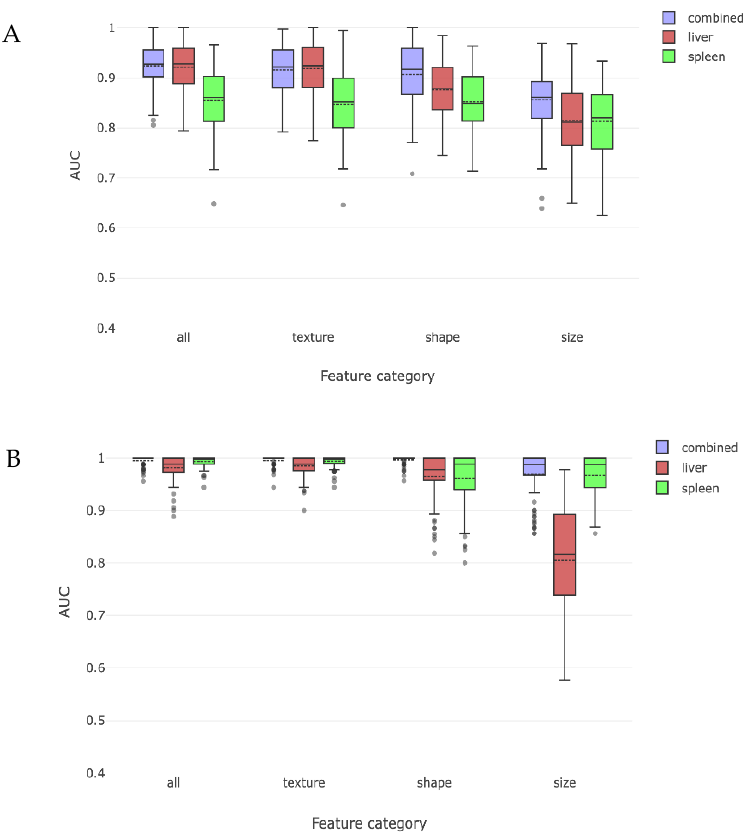
Figure 4. These two figures depict the radiomic discrimination of cirrhosis between non-cirrhosis cohort and either compensated ( A ) or decompensated ( B ) cirrhosis sub-cohorts. Discrimination is more effective for decompensated sub-cohort. Liver features are more effective than spleen features from discriminating compensated subjects, while spleen features become more effective than liver features for decompensated subjects. Texture and shape are again more effective than size features.